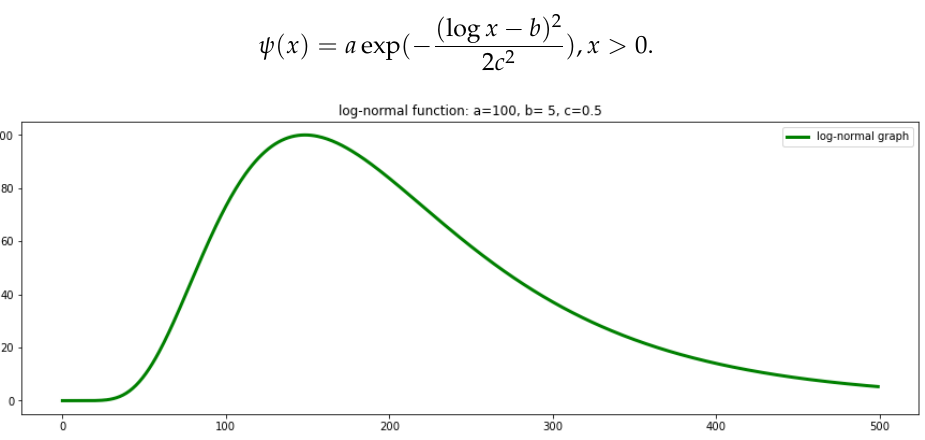
Figure 1. Log-normal